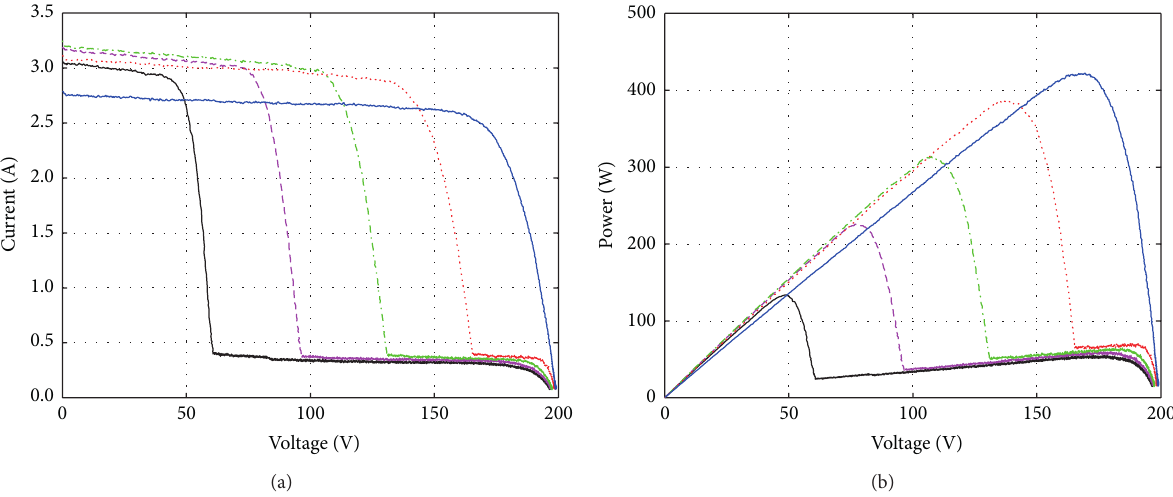
Figure 15: (a) I-U and (b) P-U characteristics of String 4 (see Figure 2) of 6 series-connected PV modules measured under partial shading conditions on December 4th, 2012. Irradiances and module temperatures measured with sensors S5 and S6 at the corresponding moments are presented in Table 4. Measurements from 1 to 5 correspond to the lines as follows: black, magenta dashed, green dash-dotted, red dotted, and